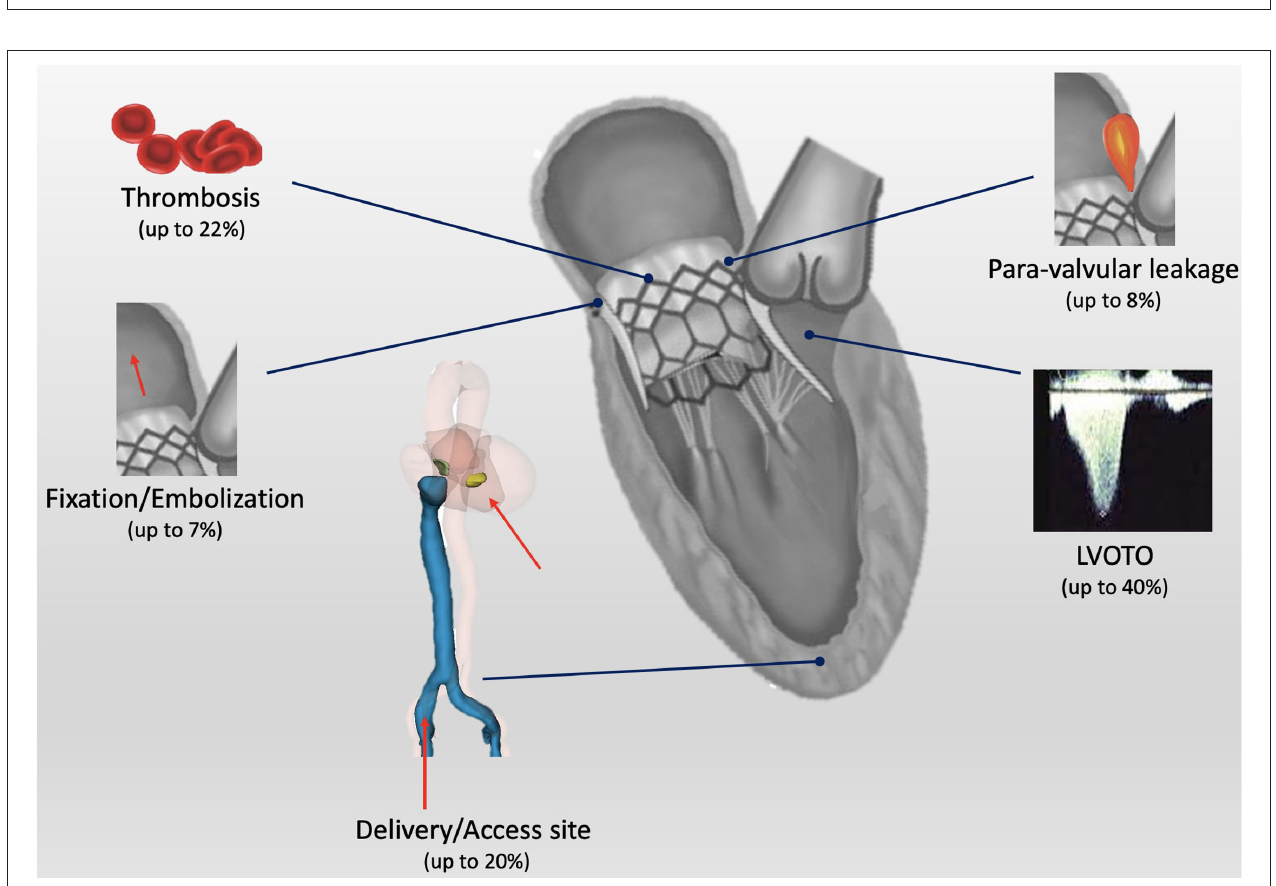
FIGURE 4 | Central illustration: current open issues for transcatheter mitral valve implantation (TMVI). LVOTO, left ventricle outflow tract obstruction.